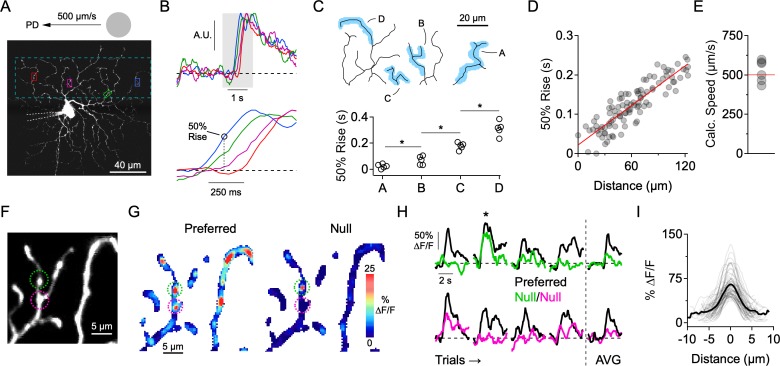
Independent activity in dendritic branches in the presence of NaV blockers.(A) 2-photon image of the ON-stratifying dendritic arbor of an ON-OFF DSGC, which was filled with a Ca2+ indicator (Oregon Green Bapta-1, 200 µM), and a NaV channel blocker (QX-314, 2 mM) through a patch electrode. The dotted box indicates the imaging area. (B) Top, Normalized Ca2+ signals for the four regions of interest (ROIs) demarcated in A. Bottom, expanded view of the shaded region, showing clear differences in onset time at the different ROIs. (C) 50% rise time from each of the four dendritic branches outlined in the above reconstruction. Asterisks indicate p<0.05, t test. (D) In an another cell, 50% rise time of the Ca2+ signals versus lateral distance along the stimulus trajectory for many small ROIs that were placed throughout the dendritic tree. The red line is a linear fit to the data. (E) The slope of the linear fit predicts the speed of the stimulus (524 ± 28 µm/s), which was nominally set to be 500 µm/s. This data set included DSGCs that were recorded with (n = 3) and without (n = 3) the presence of the NMDA receptor antagonist D-AP5 (50 µM). No differences were found in terms of the onset timing of the Ca2+ signals, so the data sets were combined. (F) 2-photon image of a section of dendrites from an ON-OFF DSGC, with two ROIs demarcated. (G) Spatial map of the peak ∆F/F for preferred (left) and null (right) motion. (H) Left, Time-varying Ca2+ responses over multiple trials extracted from the 2 ROIs in F (green and magenta). Right, Average signals over four trials. The ∆F/F maps in G are from the second trial, in which a strong Ca2+ signal in the green ROI (top) was observed during null motion. (I) Line profiles of the ∆F/F across active dendritic sites during null motion. The solid line is the average line profile, and the thin lines are from individual ROIs. Gaussian fits to the line profiles had an average FWHM of 3.0 ± 1.2 µm (µ ± s.d., n = 61 ROIs from 7 cells).Figure 2—source data 1.Calcium responses and rise time measurements.